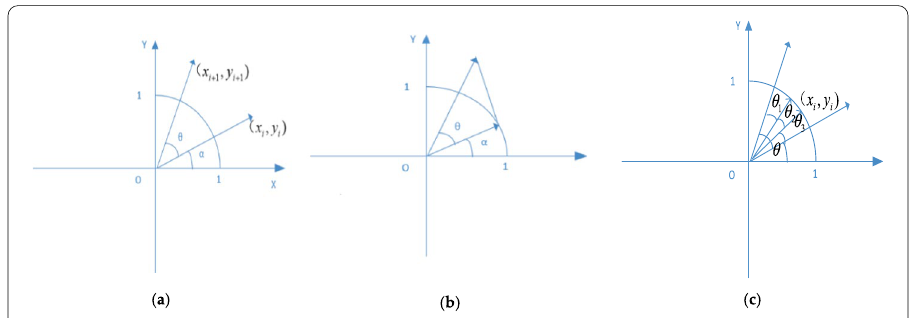
Fig. 3 Rotation mode of CORDIC algorithm in a circular system. a Vector rotation; b vector pseudo rotation; c it breaks down into smaller